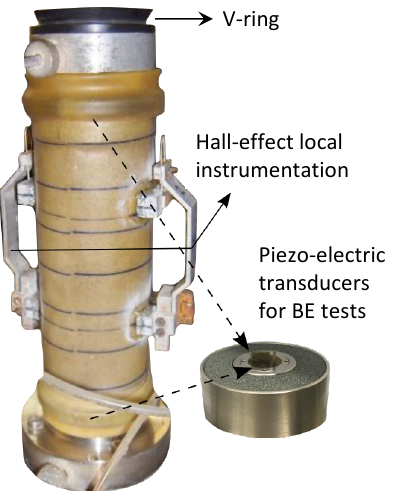
Figure 4. Soil specimen with internal instrumentation and piezo-electric